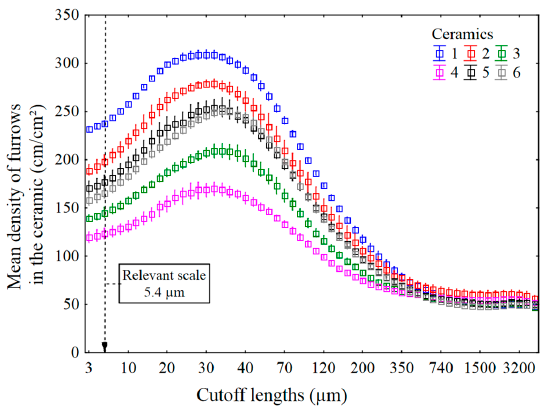
Figure 12. Mean density of furrows for all six ceramics versus multiscale cutoff lengths. Mehlum curvatures and a band pass filtering.